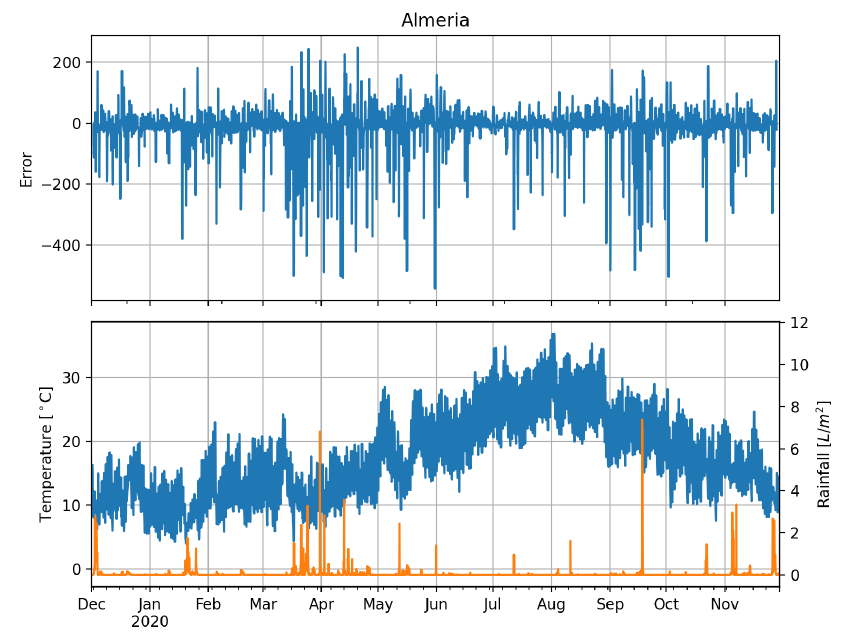
Figure 13. Error of LSTMconv Model and temperature/rainfall in Almeria from 1 December 2019 to